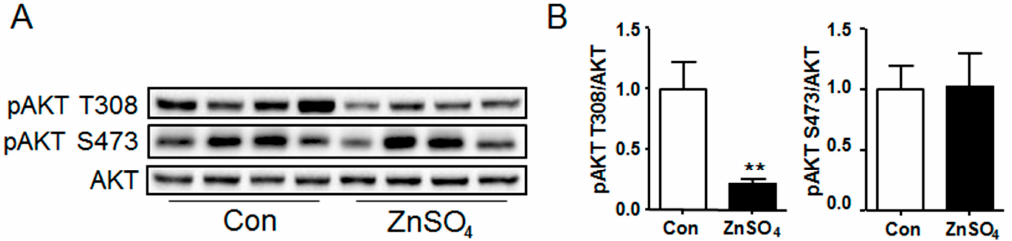
Figure 4. Chronic zinc supplementation attenuated the phosphorylation of AKT in perirenal adipose tissue. ( A ) Western blot bands of phosphorylation AKT and total AKT. Data represented 8 mice of 16 in total; ( B ) The quantification of phosphorylation AKT levels in perirenal adipose tissue ( N = 8 for each group) ( P = 0.0040 for pAKT T308). Data were shown as mean ± SEM. Con, control group; ZnSO 4 , zinc sulfate-supplemented group. ** P < 0.05 ZnSO 4 vs. Con.